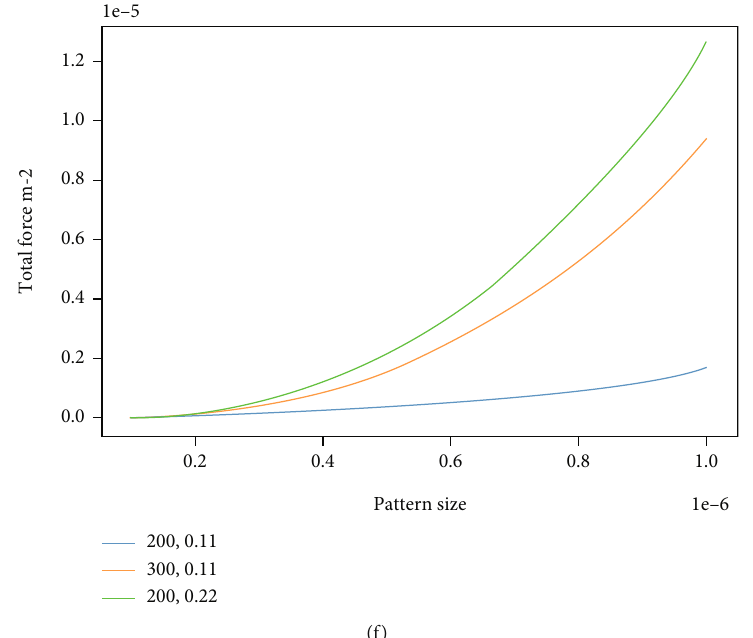
Figure 7: (a) plot of height of the PNIPAM polymer brush structure grafted on silicon oxide substrate versus initiator structure size and (b) plot of the vertical component (Equation (6)) of a polymer chain in the structure as a function of the tilting angle. (c) is a schematic of the constant density lines for the polymer brush structures grown from an initiator structure size, x , and the orientation of the polymer chains in the polymer brush structure (d) is plot of density of the polymer brush structure as a function of height, (e) is plot of the height of the polymer brush structure as a function of initiator structure size, and (f) is a plot of the repulsive force versus initiator structure size for di ff erent degrees of polymerization and